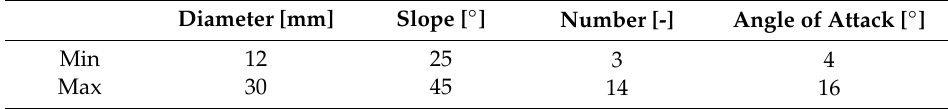
Table 1. Minimum and maximum value of the parameters defined in the Ansys / RSO.